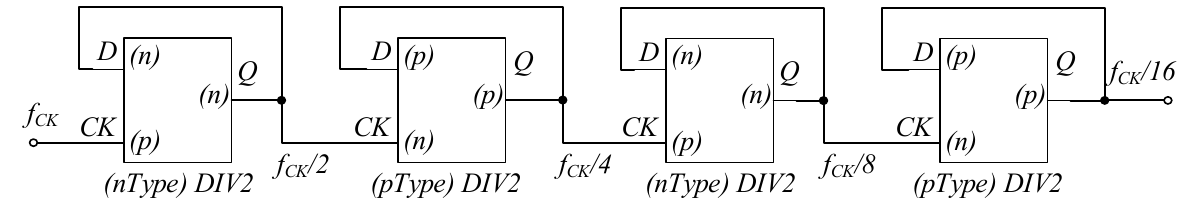
Figure 5. Frequency divider architecture with nType and pType DIV2 blocks without level shifters.